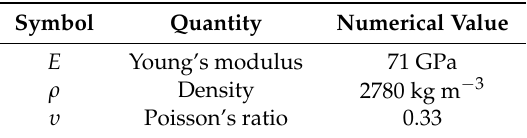
Table 1. Mechanical properties of Al-alloy